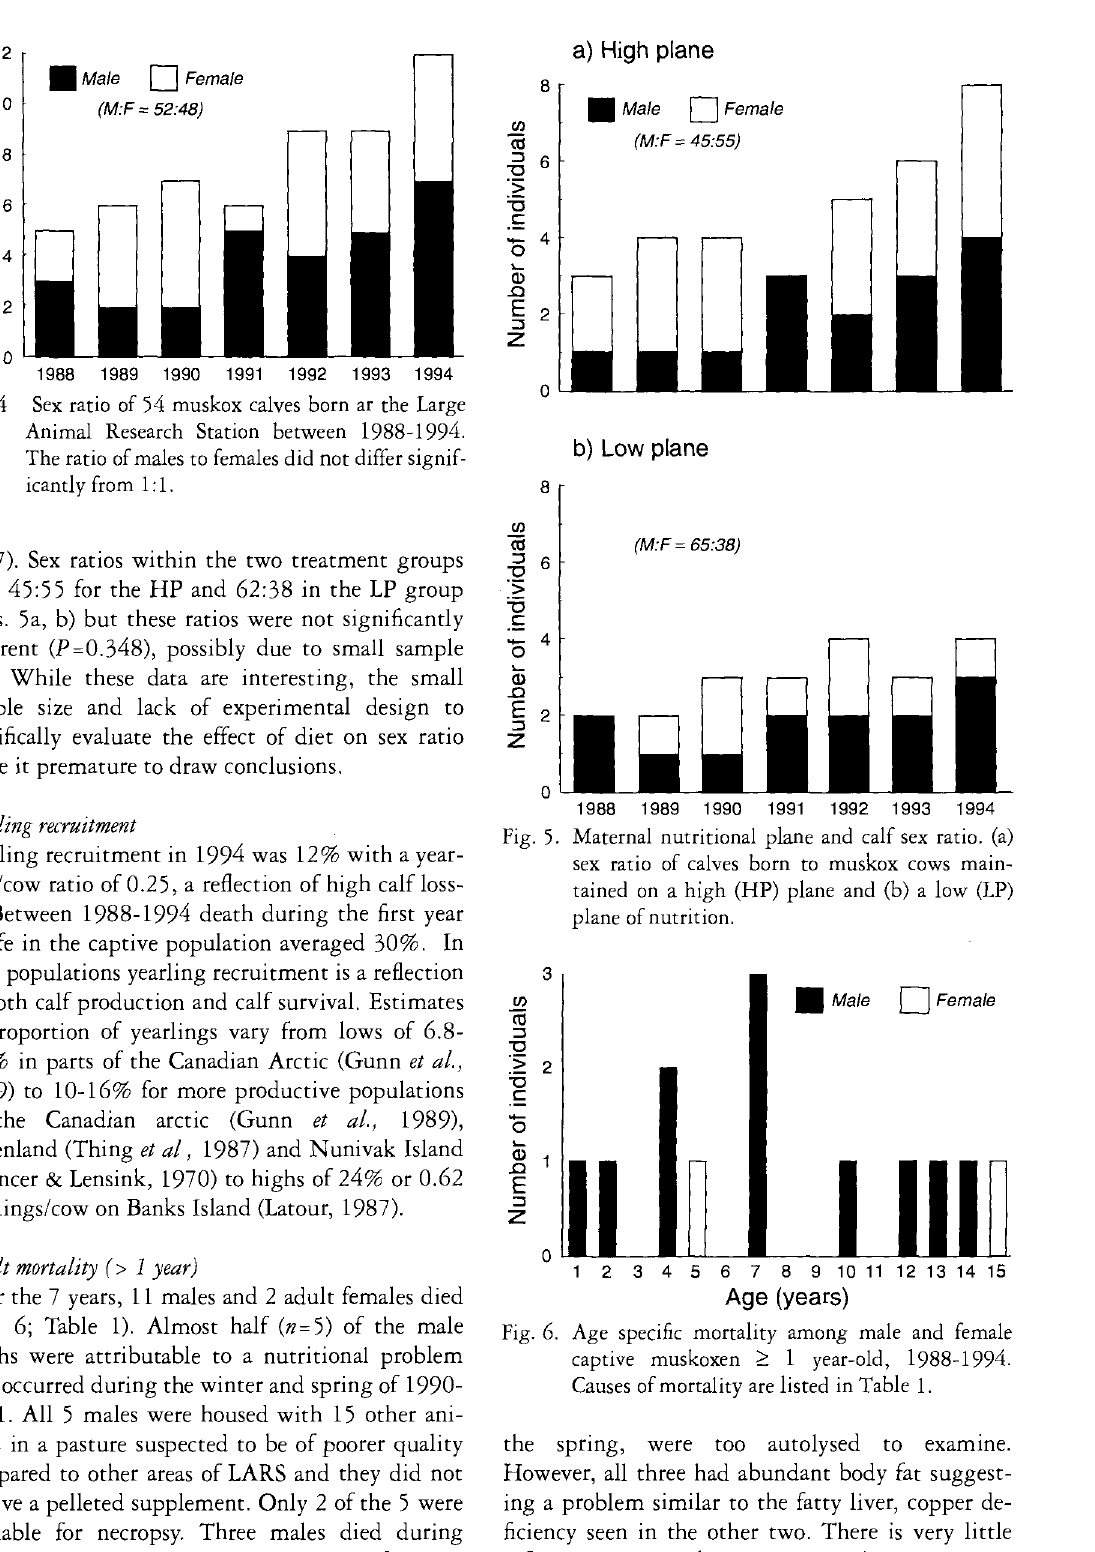
Fig. 5. Maternal nutritional plane and calf sex ratio, (a) sex ratio of calves born to muskox cows main tained on a high (HP) plane and (b) a low (LP) plane of